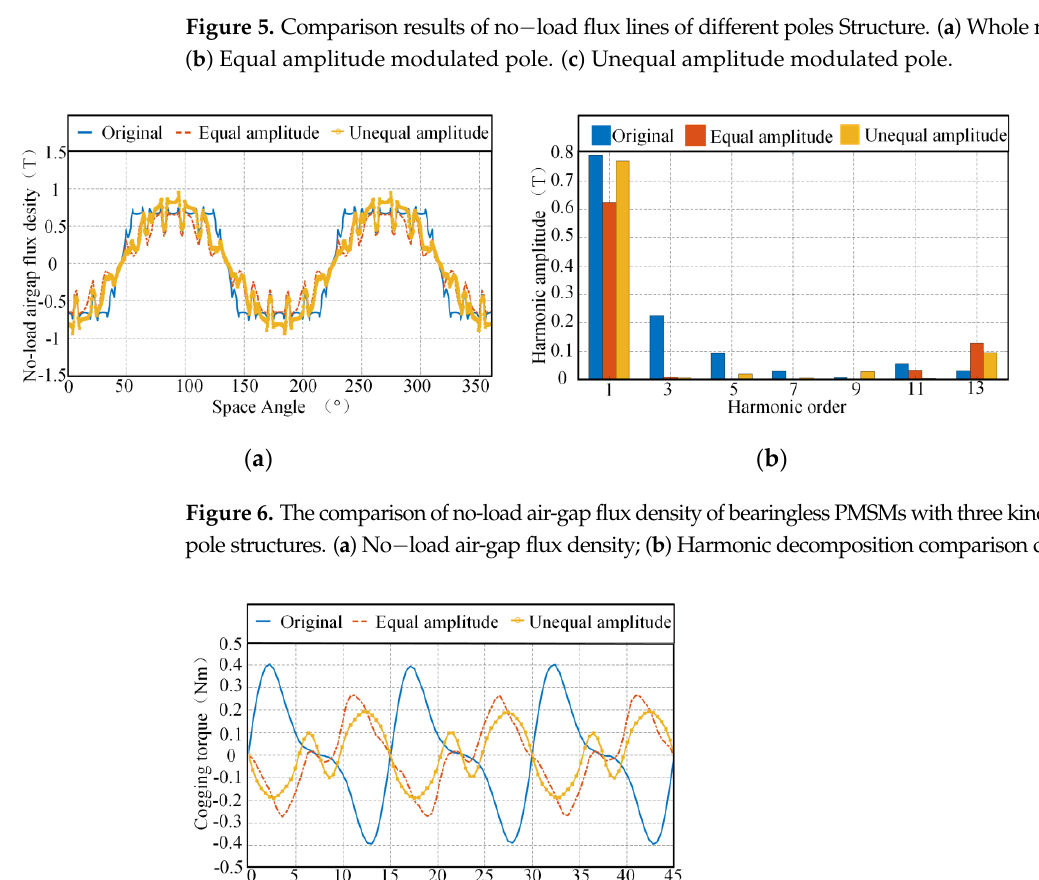
( b ) Figure 8. Load Results. ( a ) Torque; ( b ) Suspension Force. As can be seen from Figure 8a, the average torque of the motor with the whole mag- netic pole structure is 4.16 Nm and the torque fluctuation is 12.92%; the average torque of the motor with the equal amplitude modulated magnetic pole is 3.35 Nm and the torque fluctuation is 12.41%; the average torque of the motor with the unequal amplitude modu- lated magnetic pole is 4.12 Nm and the torque fluctuation is 7.35%. Compared with the motor with the whole magnetic pole. The decrease of torque fluctuation of the motor with the unequal-amplitude modulated magnetic pole is more obvious and the average torque is also improved compared with the motor with the equal amplitude modulated magnetic pole. By changing the modulation ratio under different sampling periods, the structure parameters of the permanent magnets can be flexibly adjusted. Optimized by the Taguchi method, the torque has a better effect than that of the motor with the equal amplitude modulated magnetic pole, which effectively improves the problems caused by the limited range of the modulation ratio that exist in the equal amplitude modulated magnetic poles. As can be seen from Figure 8b, the average suspension force of the motor with the whole magnetic pole is 333.55 N and its fluctuation is 7.72%; the average suspension force of the motor with the equal amplitude modulated magnetic pole is 332.25 N and its